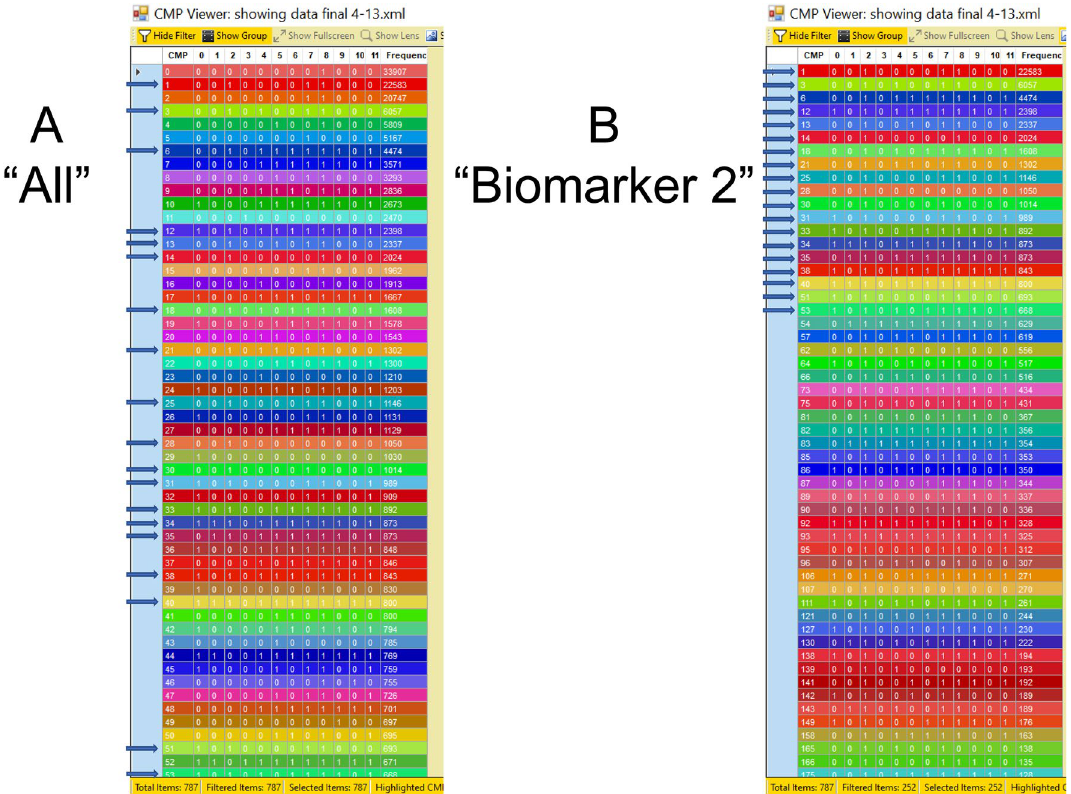
Figure 2. CMP tables. Representative CMP tables are shown from one of the samples in this study. ( A ) The 54 most abundant CMPs in the sample. The CMPs are numbered consecutively (first column on left) based on frequency (abundance; number of pixels) shown in last column. The TIS software automatically assigns the first marker as marker #0 and the most abundant CMP as number “0”. Note that column 0 (for marker 0) contains a mixture of 0s and 1s depending on the absence or presence of that marker in each CMP. Intervening columns show whether each of the markers is present (1) or absent (0) in each CMP. All of the CMPs with a “1” for marker 2 are marked with an arrow. ( B ) A similar table in which only CMPs containing marker 2 are shown. Note that for column 2 all entries show a “1”, indicating the presence of marker 2. Also, note that the CMP numbers are no longer consecutive, but list the 54 most abundant CMPs containing that marker. The first 19 CMPs are marked with an arrow and correspond to the CMPs marked with arrows in ( A ). Similar marker- specific tables were generated for each marker. Tables like this have been described previously 29,30